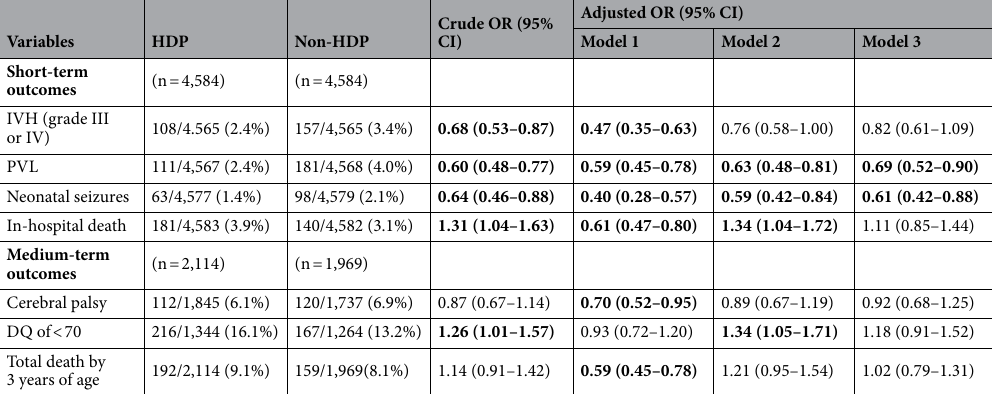
Table 2. Neurological outcomes in the HDP and non-HDP groups in univariate and multivariate analyses. Data are given as n (%). Adjusted ORs were evaluated by multivariate analyses (models 1, 2, and 3). Bold text indicates a significant association. Model 1: diabetes mellitus or gestational diabetes mellitus, histological chorioamnionitis, administration of antenatal corticosteroid, mode of delivery, gender, and birth weight were included in the logistic regression model. Model 2: diabetes mellitus or gestational diabetes mellitus, histological chorioamnionitis, administration of antenatal corticosteroid, mode of delivery, and gender were included in the logistic regression model. Model 3: diabetes mellitus or gestational diabetes mellitus, histological chorioamnionitis, administration of antenatal corticosteroid, mode of delivery, gender, and SGA were included in the logistic regression model. HDP, hypertensive disorders of pregnancy; IVH, intraventricular haemorrhage; PVL, periventricular leukomalacia; DQ, developmental quotient; OR, odds ratio; CI, confidence interval; SGA, small for gestational